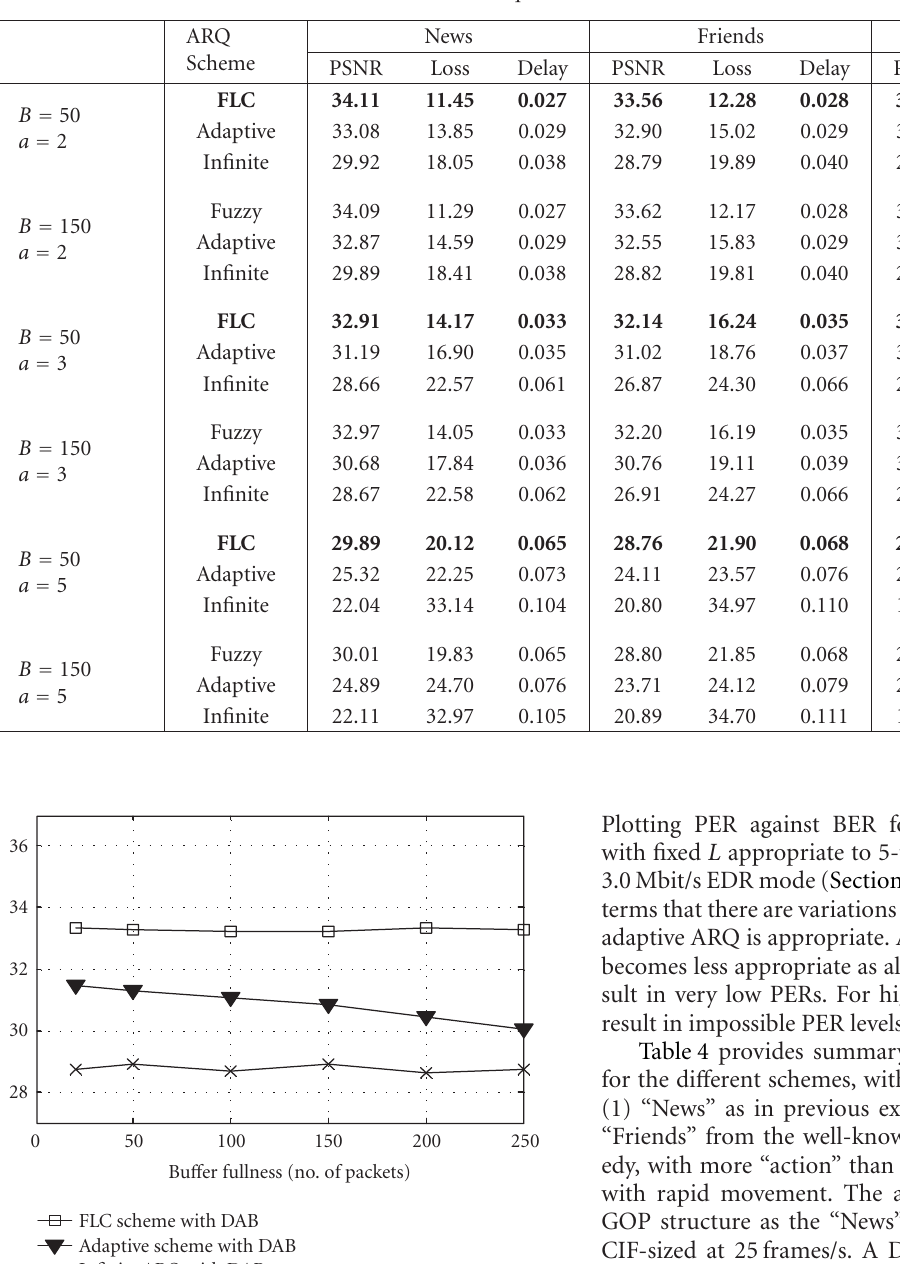
Table 4: Summary statistics for various ARQ control schemes, all with DAB, giving mean PSNR in dB, mean packet loss rate as a percentage, mean delay in seconds (s), with bu ff er size B in numbers of Bluetooth packets, and channel condition factor a being higher for worse wireless channel conditions. The results are for three di ff erent video sequences.